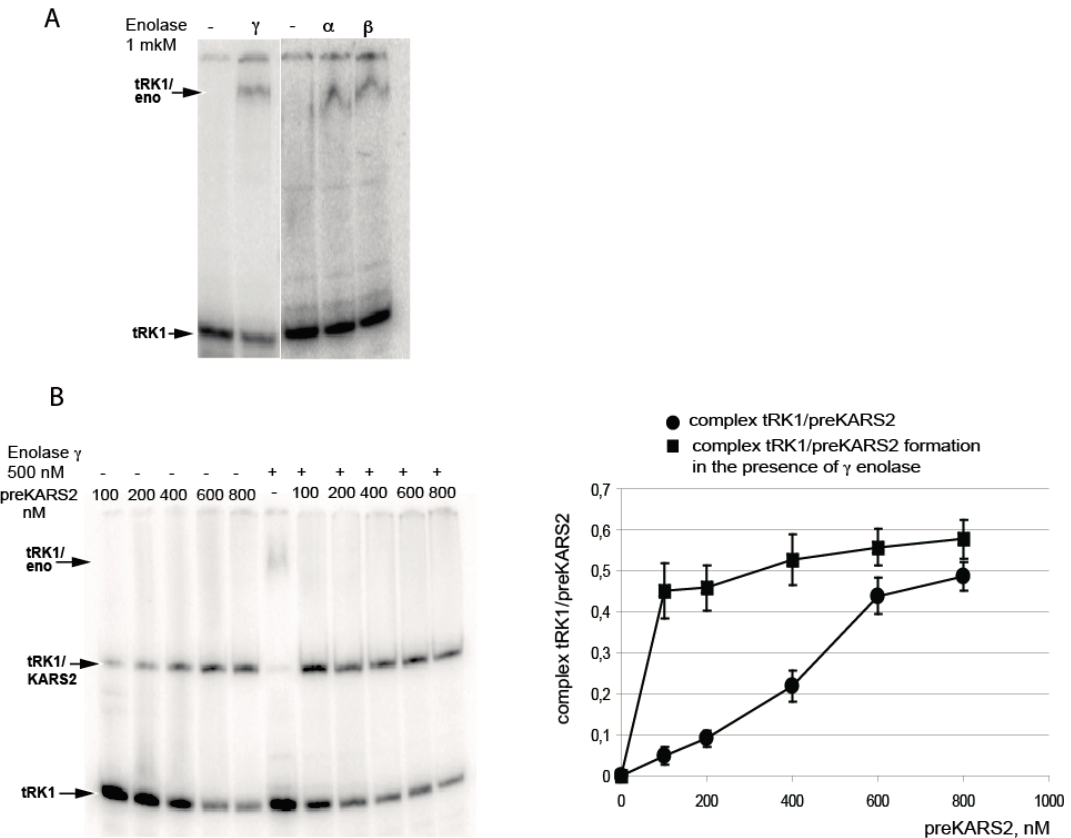
Figure 4. Analysis of RNA-protein interactions by electrophoretic mobility shift assay. ( A ) Autoradiographs of native PAGE-separations of labeled tRK1 in the presence of purified human enolase isoforms; ( B ) The effect of γ enolase on tRK1–KARS2 complex formation. Autoradiograph of the native gel is shown at the left , quantification of tRK1–KARS2 complex formation—at the right . TRK1, the band corresponding to the free tRK1; RNA-protein complexes are shown with arrows. One example from three independent experiments is